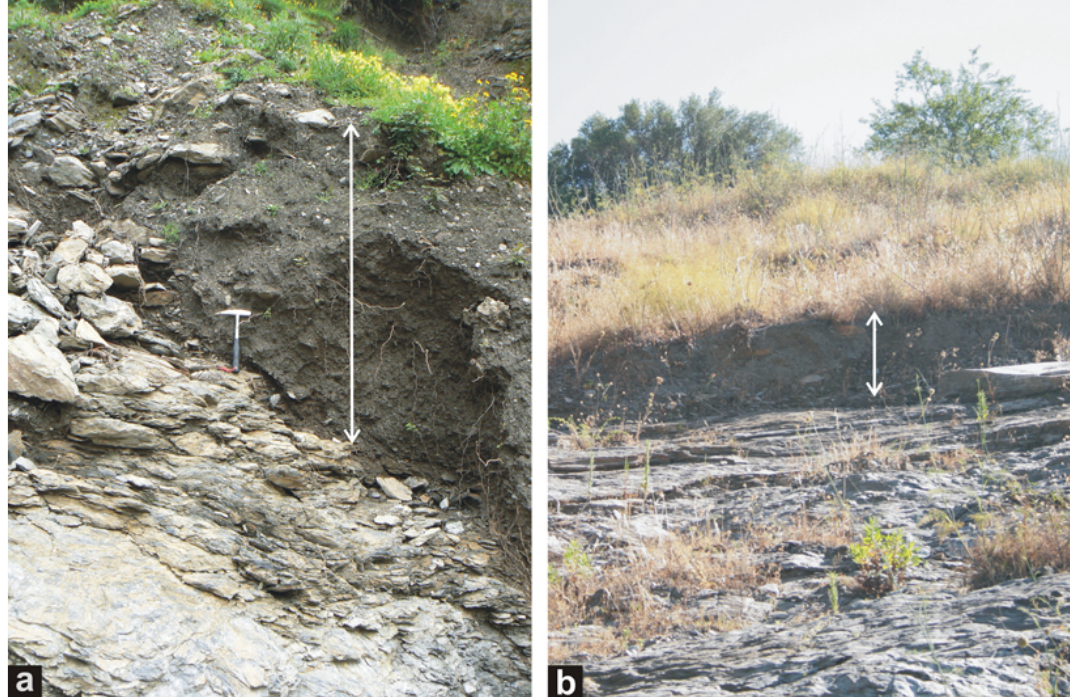
Fig. 3. Landslides scars: lateral (a) and frontal (b) view. Note the sharp contact between the colluvium (approximately 1.0m thick) and the